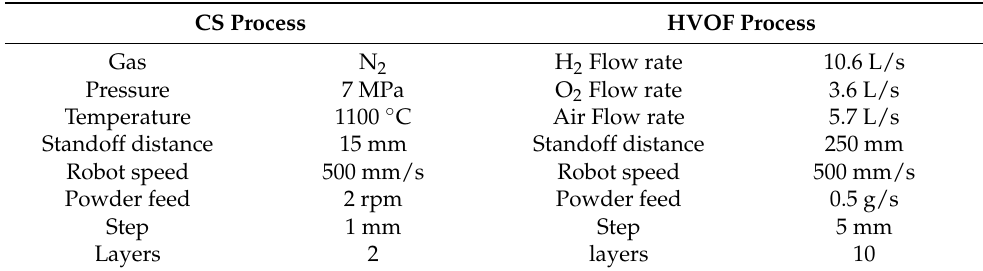
Table 2. Process parameters of CS and